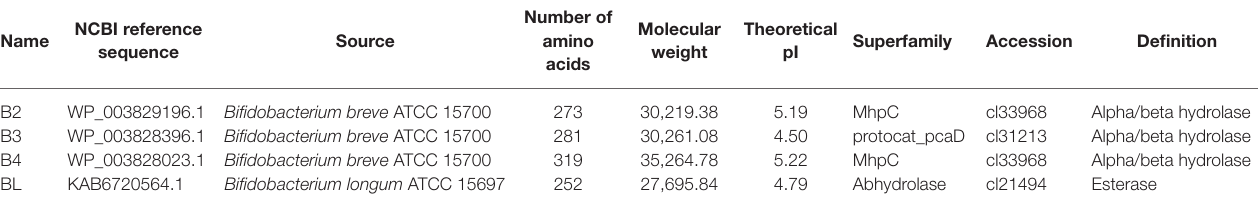
TABLE 1 | The information of esterases in Bifidobacteria